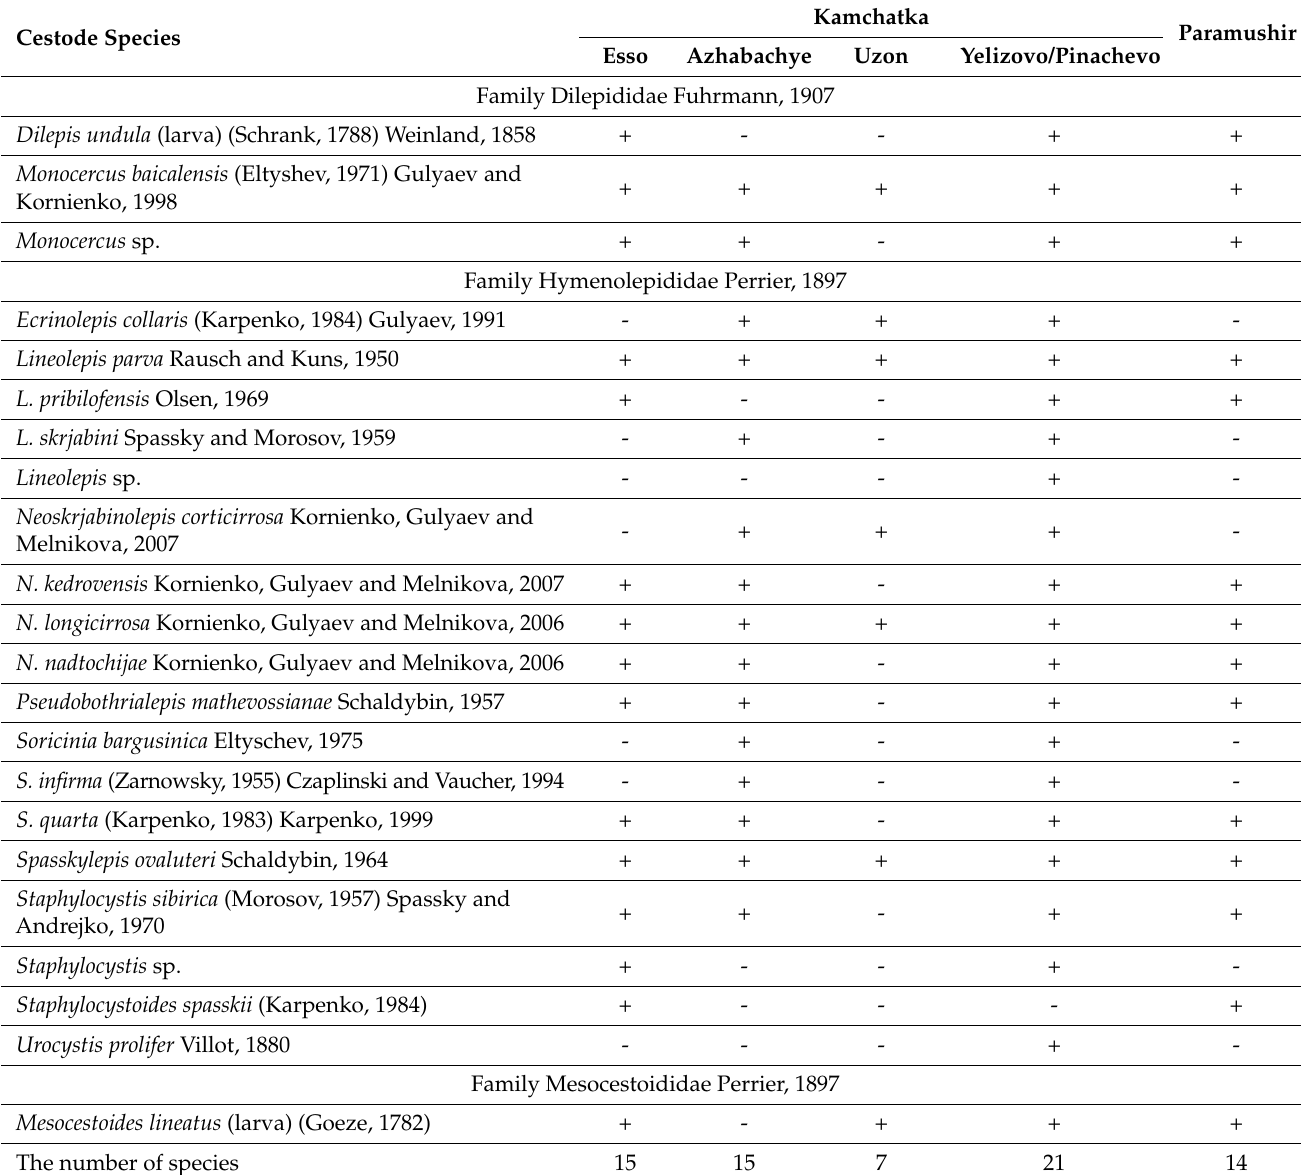
Table 1. The occurrence of shrew cestodes at different sites in Kamchatka and Paramushir